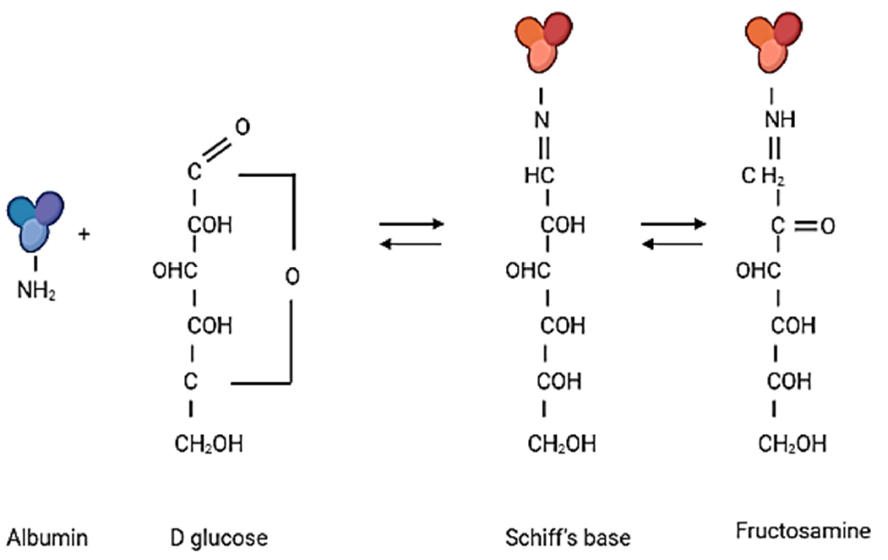
Figure 14. The first step of albumin glycation (the drawing was created in Biorender.com, accessed 9 September